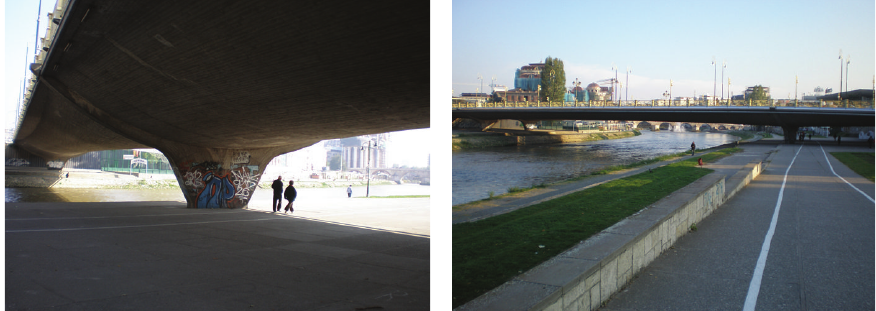
Figure 17: The twin bridge “Goce Delcev,” across rivers Vardar, Skopje, and Macedonia.